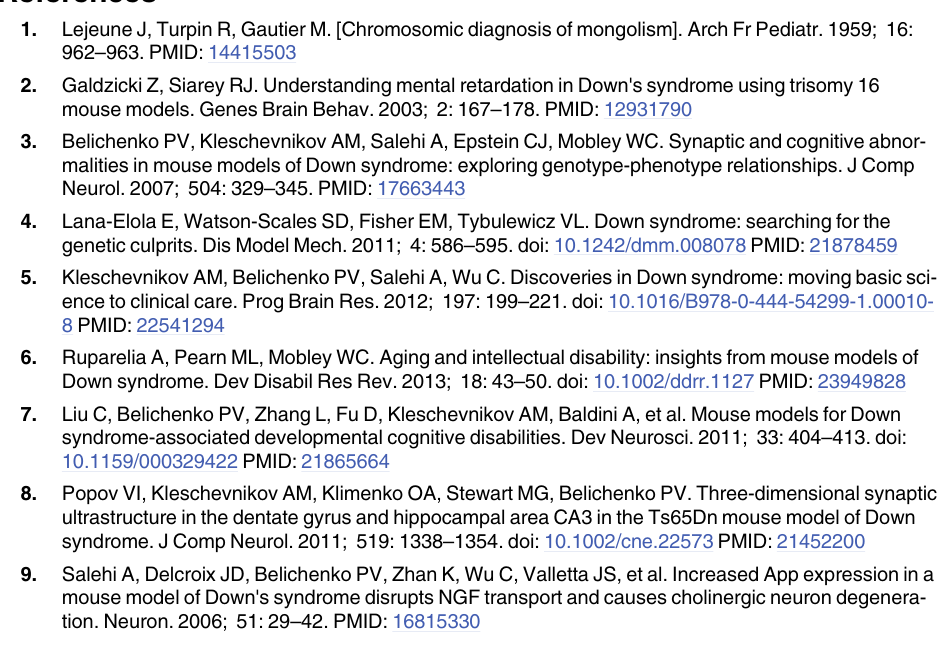
S1 Table. Correlation coefficients between the measured behavioral parameters and the animal ’ s age. Neither of the correlations reached the level of significance suggesting no impact of the animal ’ s age on the measured behavioral